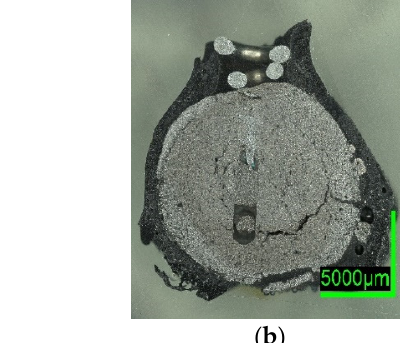
Figure 9. Digital microscope images of ( a ) C750-ULC-2; ( b ) C800-ULC-4, both dipped into liquid ULC steel.